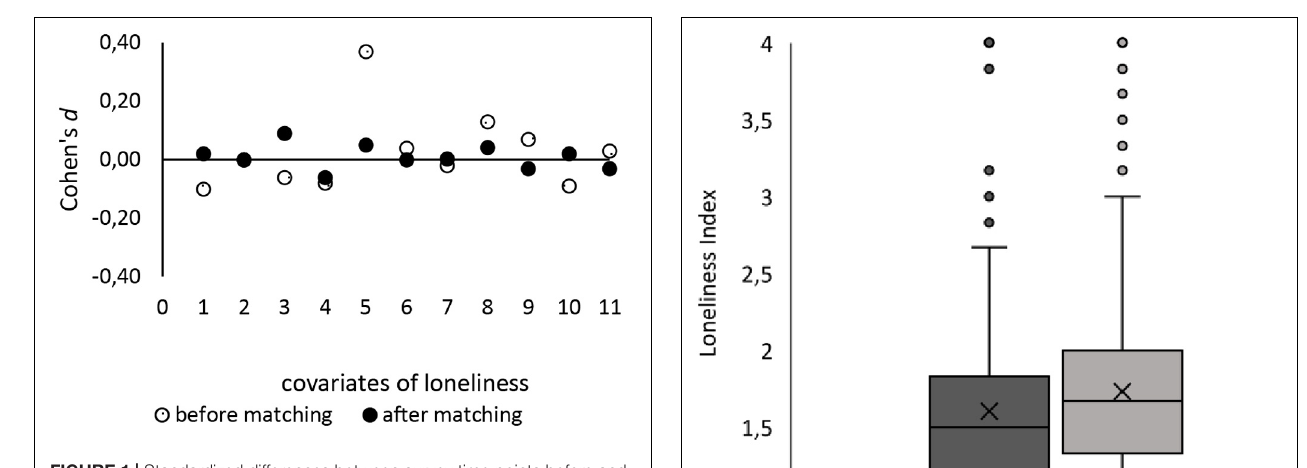
FIGURE 1 | Standardized differences between survey time points before and after PSM. The figures demonstrate the contraction of the standard differences of covariates of loneliness before and after PS matching. Numbers on the x -axis denote the covariates: 1 = gender, 2 = marital status, 3 = number of living children, 4 = employment status, 5 = education level, 6 = number of people in the household, 7 = level of care allowance, 8 = income level, 9 = subjective health, 10 = age, 11 = social support.